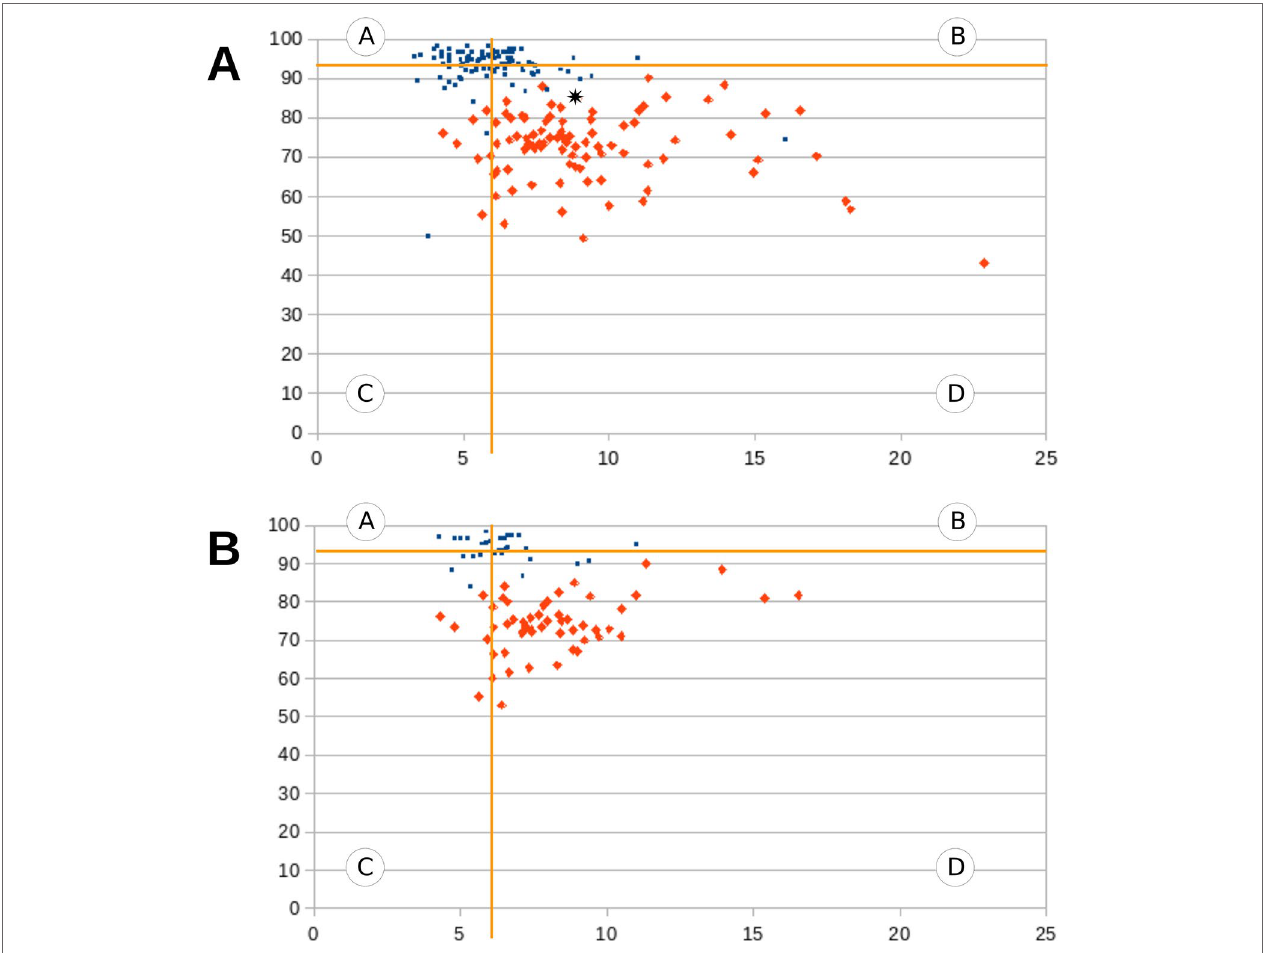
FIgURe 3 | (A , B) Graphical differentiation of the CG and the SG ( Figure 3A ), as well as the two matched subgroups ( Figure 3B ). Each participant’s social cognitive performance was symbolized by a single point defined by their summary response time (along the x-axis) and summary response rate (along the y-axis). The blue dots represent healthy participants and the red dots represent schizophrenic participants. The diagrams were divided into four fields by a horizontal and a vertical line. The horizontal line represents the mean response rate of the CG, and the vertical line represents the mean response time of the